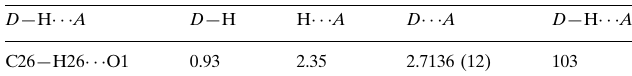
Hydrogen-bond geometry (A˚ , (cid:1)